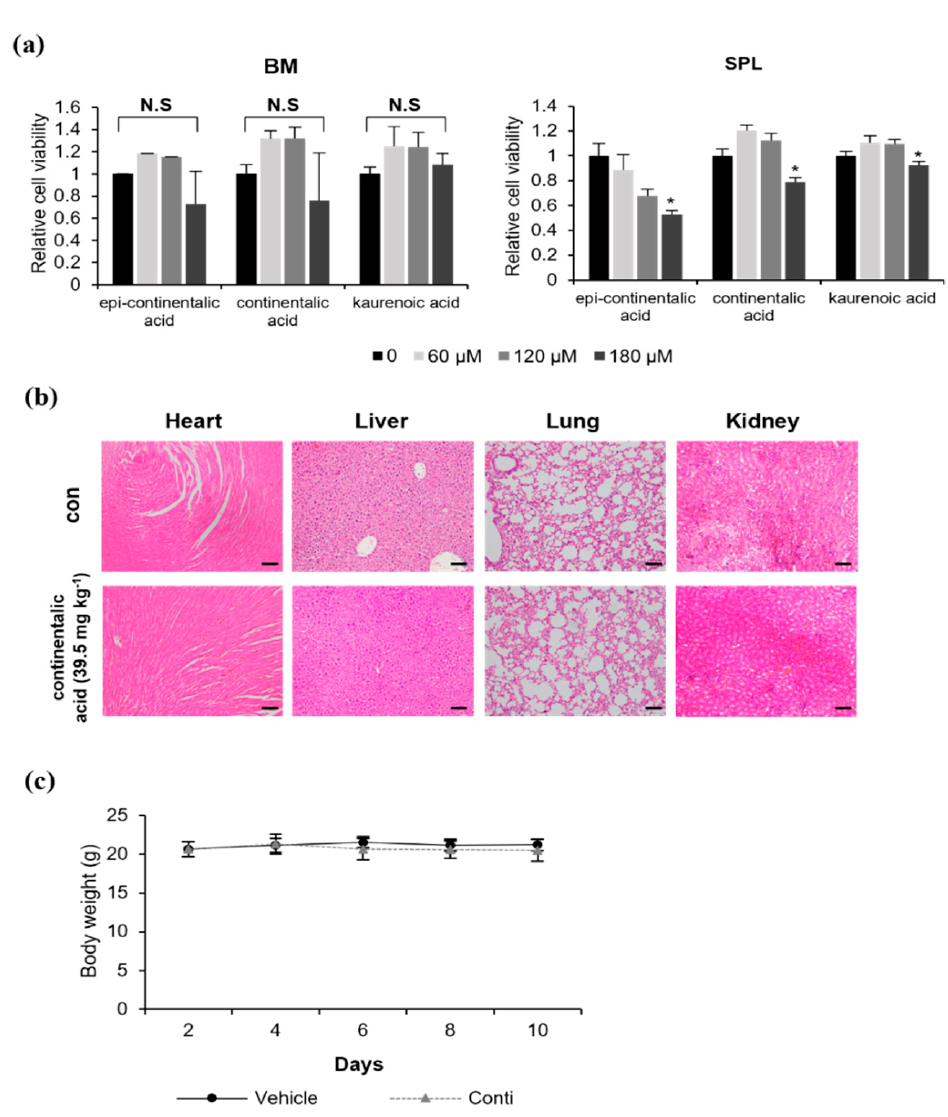
Figure 4. Epi -continentalic acid, continentalic acid, and kaurenoic acid exhibit low toxicity towards normal cells in vitro and in vivo. ( a ) Bone marrow cells (BM) and splenocytes (SPL) isolated from wild-type C57BL/6 mice were treated with epi -continentalic acid, continentalic acid, and kaurenoic acid (0, 60, 120, and 180 µ M) for 24 h, followed by assessment of cell viability by MTS assays. Statistical significance was calculated using the two-tailed one-way analysis of variance (ANOVA) test (* p < 0.05). ( b ) A vehicle (50 µ L of DMSO) or continentalic acid (130 µ M) was injected into athymic nude mice (BALB/c-nu, 4 weeks old, male, n = 5 per treatment group) intraperitoneally daily for 10 days. The hearts, livers, lungs, and kidneys removed from the mice were fixed with 4% paraformaldehyde and embedded in paraffin. For histological analysis, tissue sections were stained with hematoxylin and eosin and observed at 100 × magnification under the microscope. Scale bar, 100 µ m. ( c ) Mouse body weights were measured every 2 days for 10 days during the